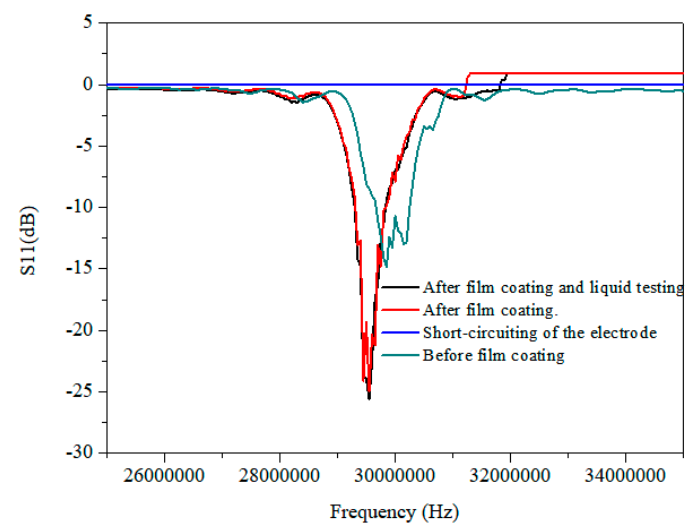
Figure 5. The frequency domain characteristic results under different conditions.